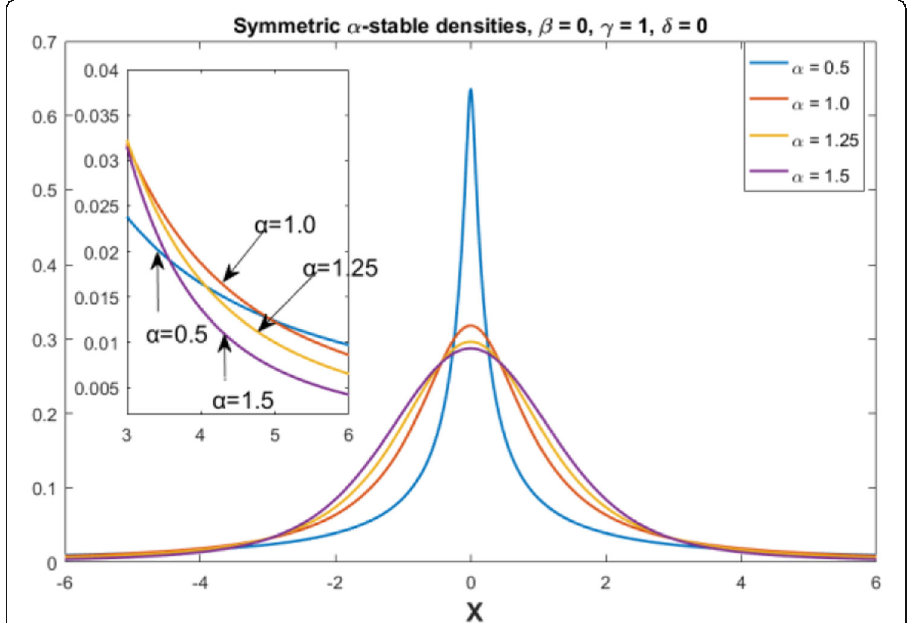
Fig. 1 Symmetric α -stable probability density functions with different α ( β = 0, γ = 1, ξ = 0)